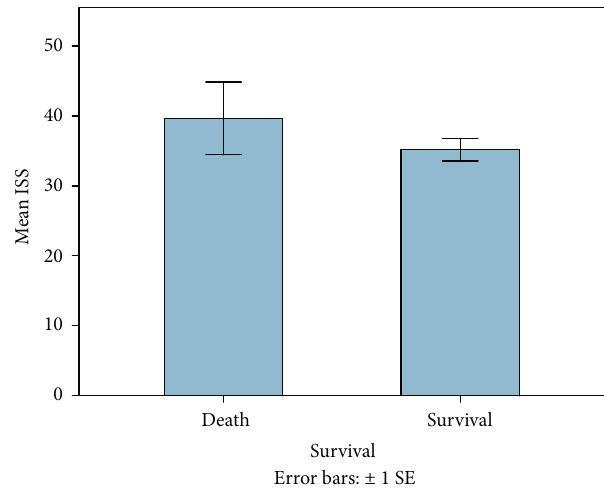
Figure 2: Mean NISS of all patients according to age decades ( n = 60 ). The results show higher NISS scores in patients aged between 20 and 40 years and again between the ages of 70 and 90 years.